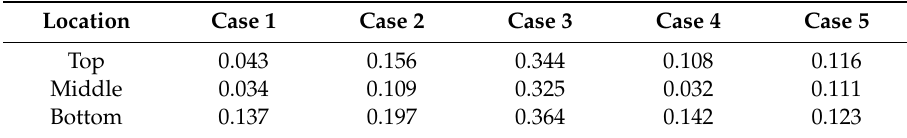
Figure 14. Cross section of L3 of Case 2: ( a ) top; ( b ) middle; ( c ) bottom. Table 5. Measured average unfilled height (mm).